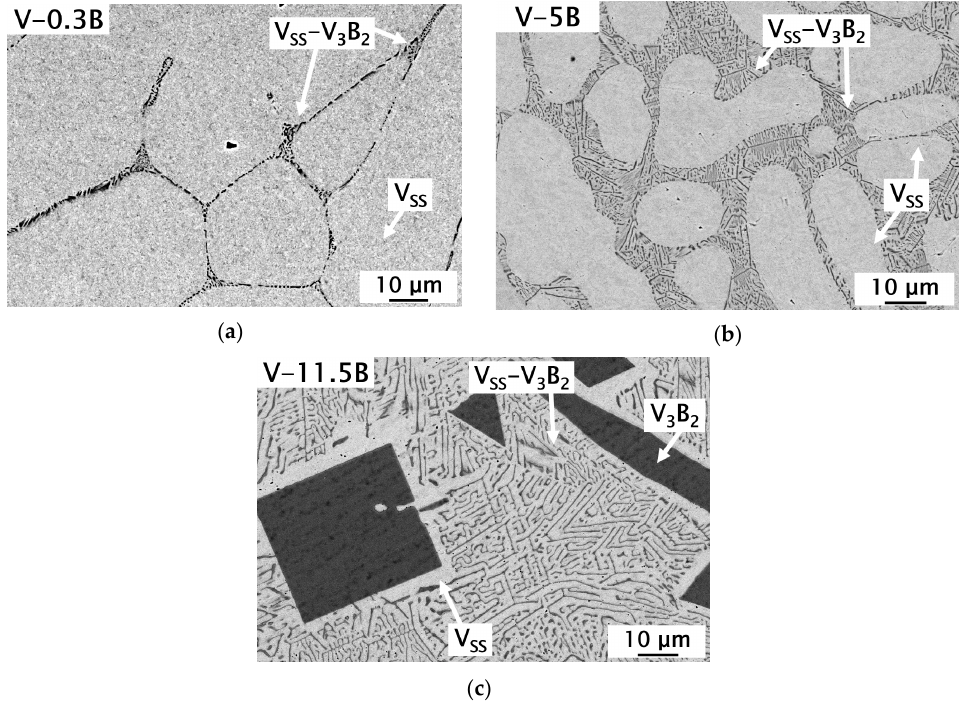
Figure 3. Scanning electron microscopic images in the backscattered electron mode (SEM ‐ BSE), showing the as ‐ cast microstructure of the binary V ‐ B alloys: ( a ) V ‐ 0.3B; ( b ) V ‐ 5B; ( c ) V ‐ 11.5B with small V SS halos around V 3 B 2 primary phase. around V 3 B 2 primary